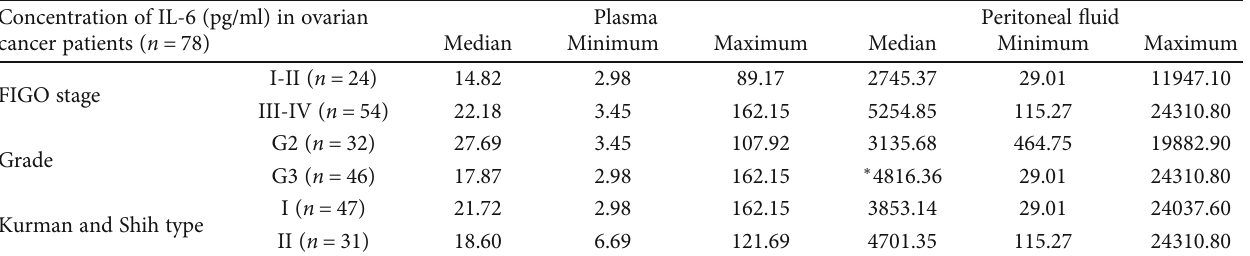
Kurman and Shih type